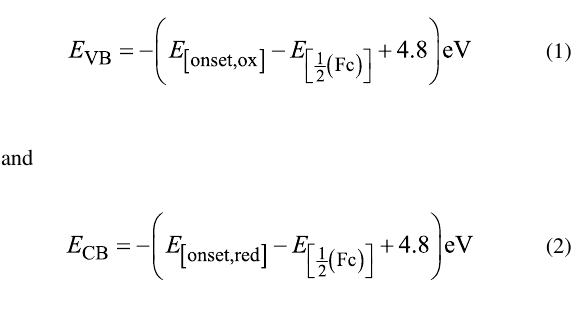
FeS 2 NCs is shown in Figure 3b. The results verify that the sizes of the NCs lie within the nanoscale regime (about 15 to 25